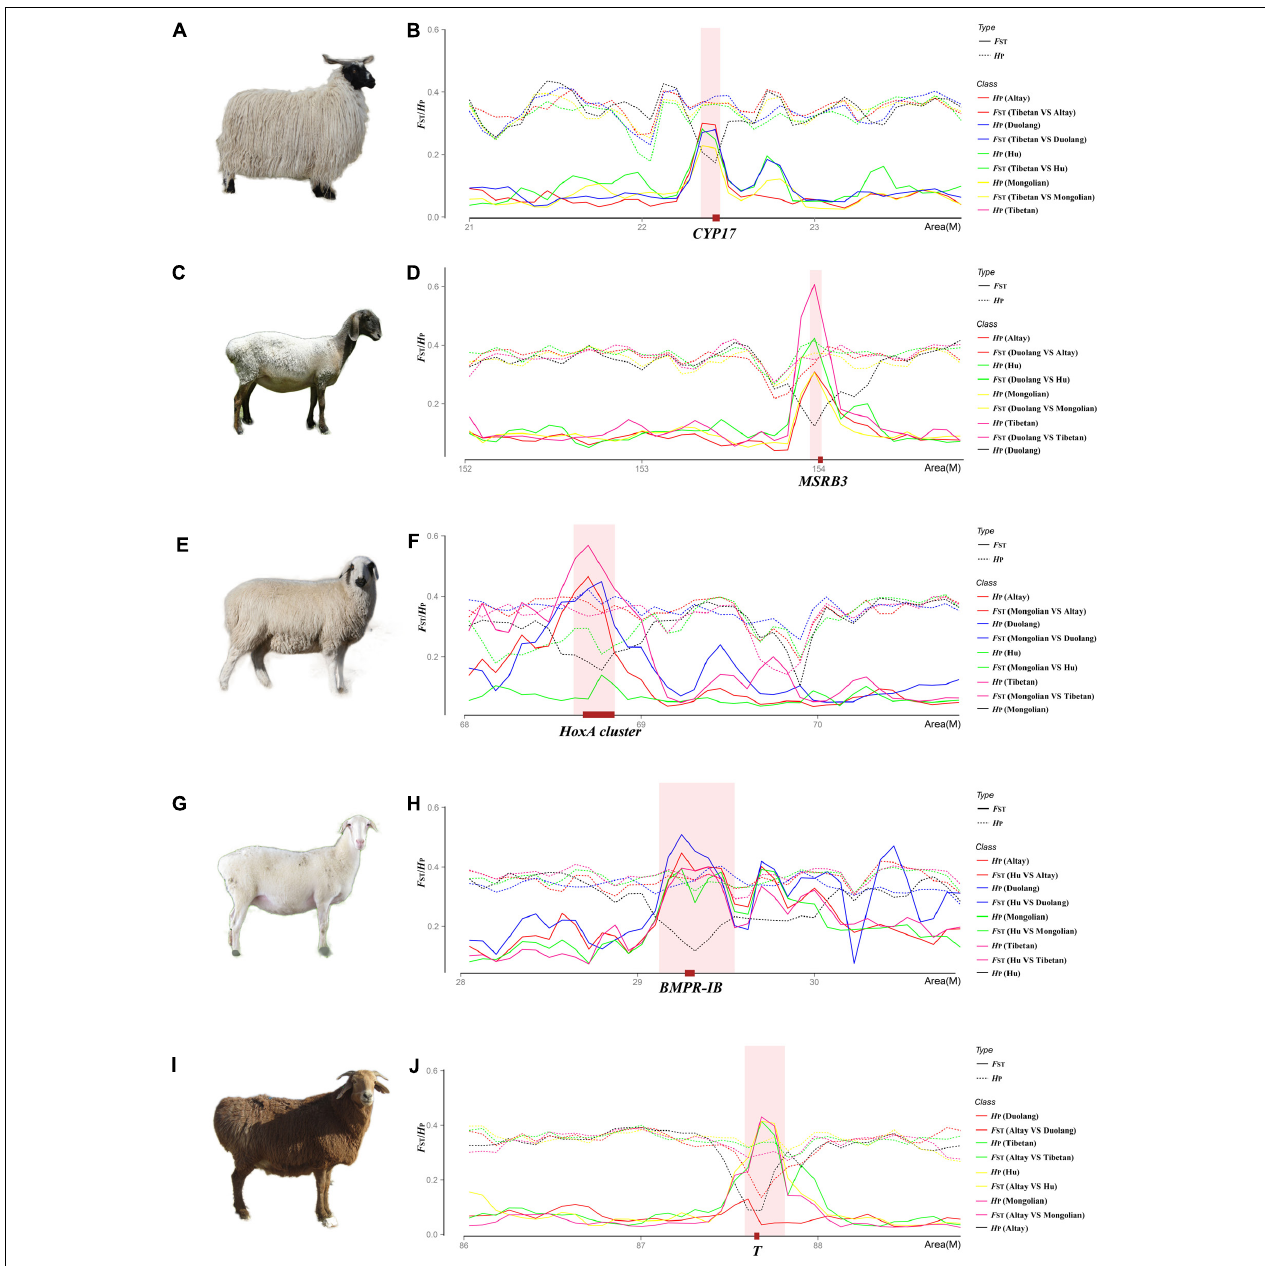
FIGURE 4 | Specific selection regions in each indigenous Chinese sheep breed. (A) Image of Tibetan sheep. (B) Signatures of the selective sweep of the CYP17 gene region associated with hypoxia adaptability in Tibetan sheep. (C) Image of Duolang sheep. (D) Signatures of the selective sweep of the MSRB3 gene region associated with ear size in Duolang sheep. (E) Image of Mongolian sheep. (F) Signatures of the selective sweep of the HoxA gene cluster region associated with vertebral number variations in Mongolian sheep. (G) Image of Hu sheep. (H) Signatures of the selective sweep of the BMPR-IB gene region associated with litter size in Hu sheep. (I) Image of Altay sheep. (J) Signatures of the selective sweep of the T gene region associated with the short-tailed phenotype in Altay